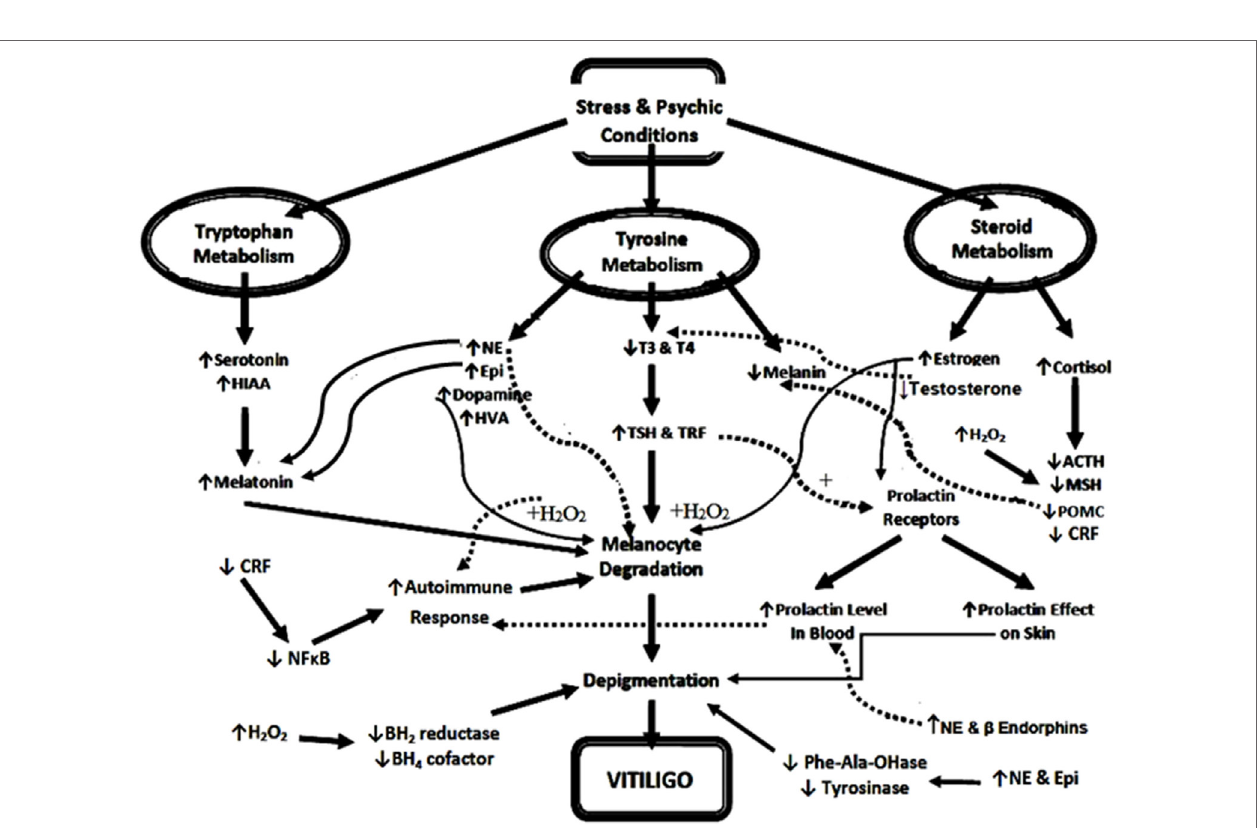
FigUre 7 | Diagrammatic illustration of possible neuro-endocrinal pathogenesis of vitiligo. Abbreviations: NE, norepinephrine; Epi, epinephrine; T 3 , triiodothyronine; T 4 , thyroxine; TSH, thyroid-stimulating hormone; CRF, corticotrophin-releasing factor; TRF, thyrotrophic-releasing factor; MSH, melanocyte-stimulating hormone; POMC, proopiomelanocortin; NF- κ B, nuclear factor kappa B; BH 4 , tetrahydrobiopterin; BH 2 , dihydrobiopterin; ACTH, adrenocorticotrophic hormone; HVA, homo-vanillic acid; HIAA, hydroxyindoleacetic acid; H 2 O 2 , hydrogen peroxide; Phe-Ala-OHase, phenylalanine hydroxylase. ↑ and + , increase or activate, ↓ or − , decrease or inhibits, the solid lines mean above the page plane, whereas the dotted lines mean below page plane to differentiate between the beginning and the end of each arrow.